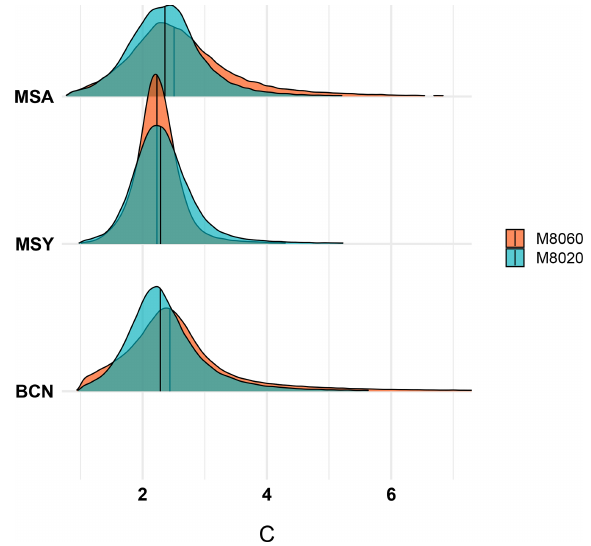
Figure 2. Density distribution of the C factor for each filter type, M8020 and M8060, as obtained through Eq. (5) using both the at- tenuation coefficient from the AE33 and the absorption coefficient from the MAAP. The vertical line represents the median value of each